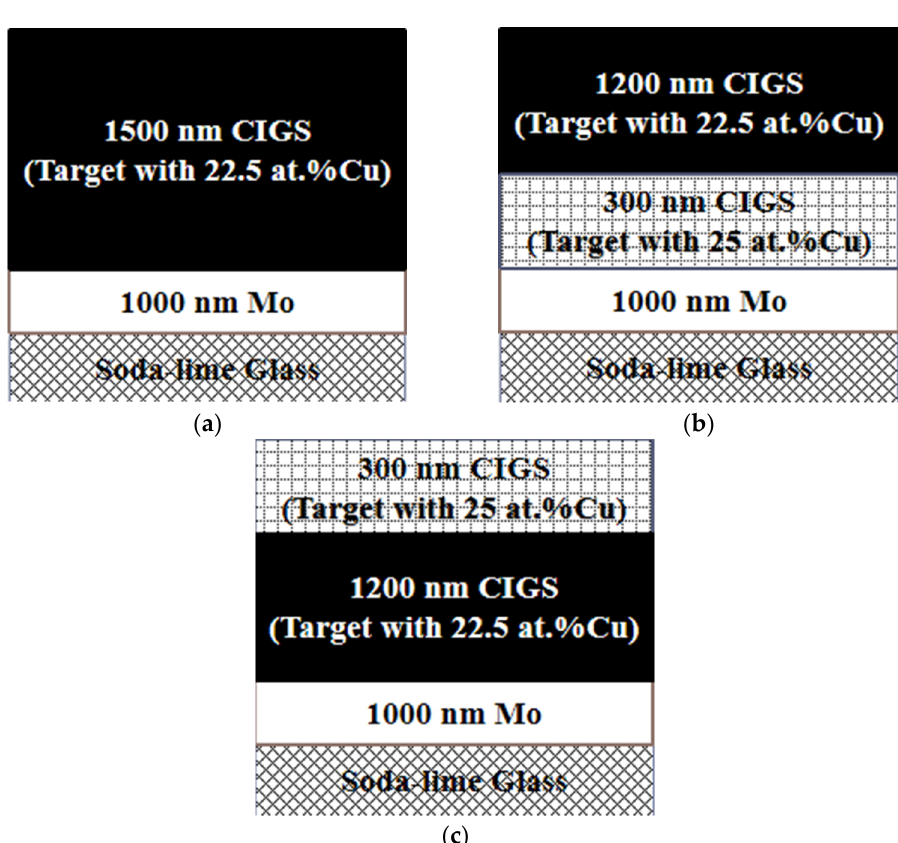
Figure 1. The sketch map of precursor layer structures. ( a ) Structure 1: 1500 nm CIGS film with 22.5 at. % Cu. ( b ) Structure 2: 1200 nm CIGS film with 22.5 at. % Cu on 300 nm CIGS film with 25 at. % Cu. ( c ) Structure 3: 300 nm CIGS film with 25 at. % Cu on 1200 nm CIGS film with 22.5 at. % Cu.